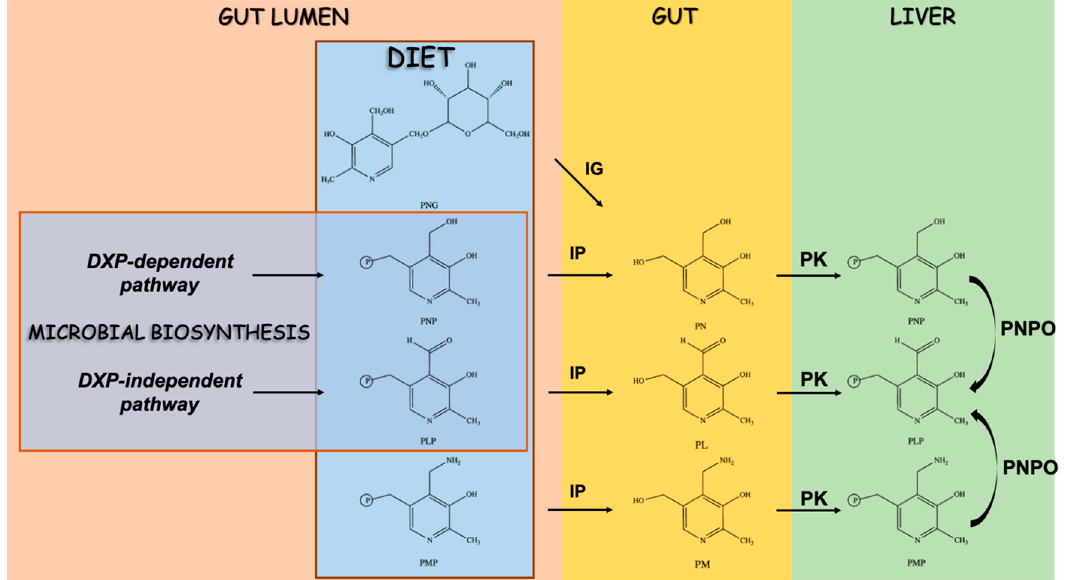
Figure 4. Schematic overview of the microbial and host B6 vitamers metabolic pathways. The panel depicts the pathways of B6 vitamer metabolism in the gut microbiota (pink, left side) and in the host, with particular reference to the gut (yellow, central) and the liver (green, right side) metabolic pathways. The panel highlights the different contribution of the microbiome and the diet to the host vitamin B6. Details are described in the text. DXP: deoxyxylulose 5-phosphate; IG: intestinal glycosidase; IP: intestinal phosphatase; PK: pyridoxal kinase; PL: pyridoxal; PLP: pyridoxal 5 ′ -phosphate; PM: pyridoxamine; PMP: pyridoxamine 5 ′ -phosphate; PN: pyridoxine; PNG: pyridoxine glucoside; PNP: pyridoxine phosphate; PNPO: pyridox(am)ine phosphate oxidase. The phosphorylated forms PNP, PLP, and PMP are dephosphorylated by intestinal